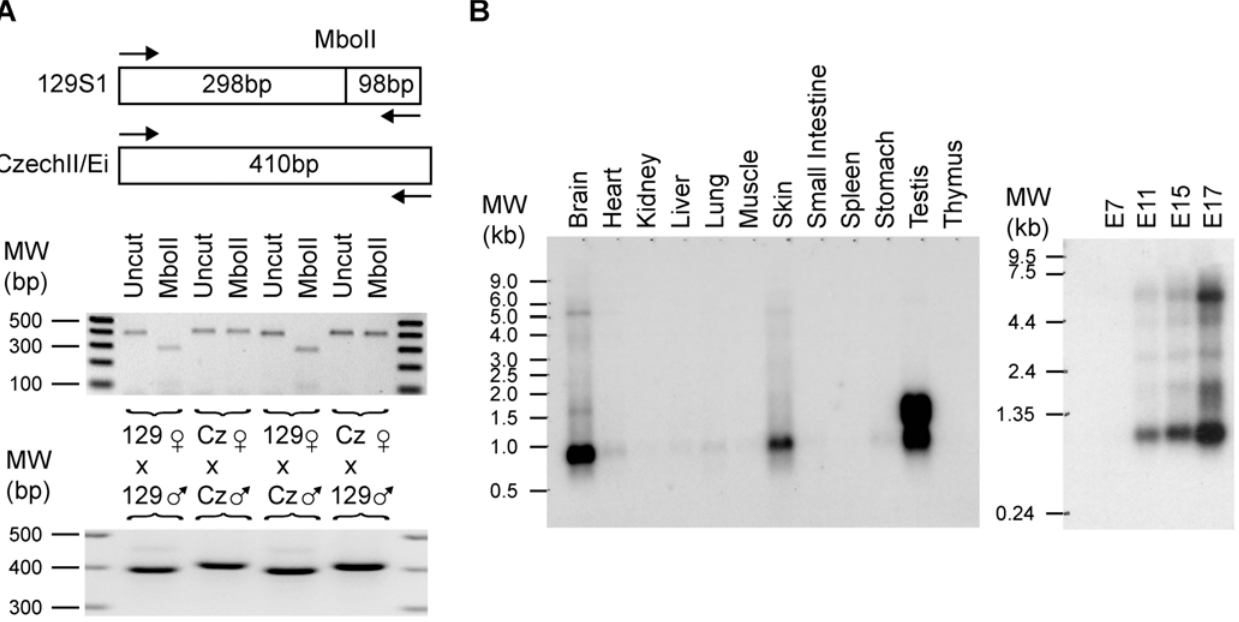
Figure 10. Meg9 transcripts are derived from the maternal allele and are widely expressed in adult tissues. (A) Meg9 alleles between 129S1 and CzechII/Ei differ by a polymorphism that abolishes a MboII restriction site in the CzechII/Ei allele. Moreover, the CzechII/Ei allele harbors a fourteen nucleotide long insertion. RT-PCR (bottom) and MboII restriction digestion (top) of the Meg9 RT-PCR products demonstrated that this gene is maternally expressed. (B) Northern demonstrate that Meg9 , like Dlk1 (see Figure 3B), is widely expressed in adult tissues and that the abundance of its transcripts increase as a function of embryonic age.